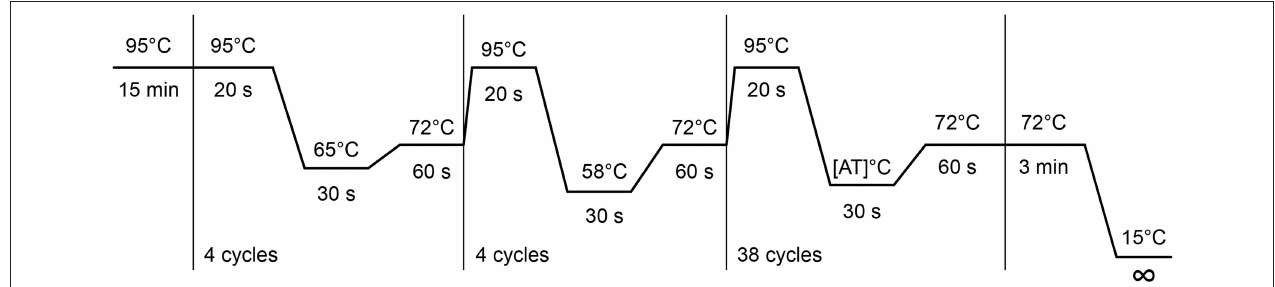
FIGURE 2 | Step-down bisulfite